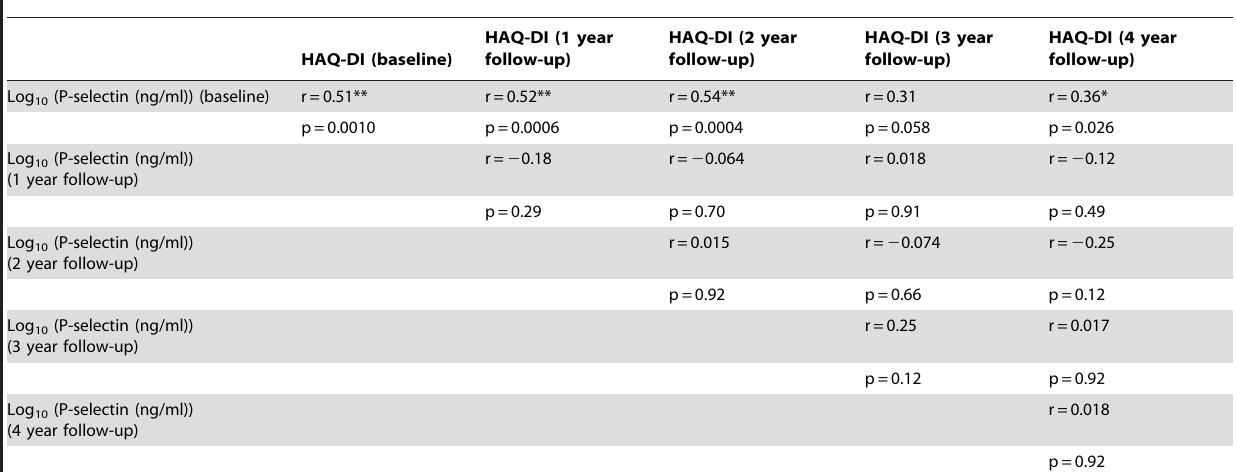
Table 4. The associations between P-selectin levels and subsequent HAQ-DI in patients with SSc.